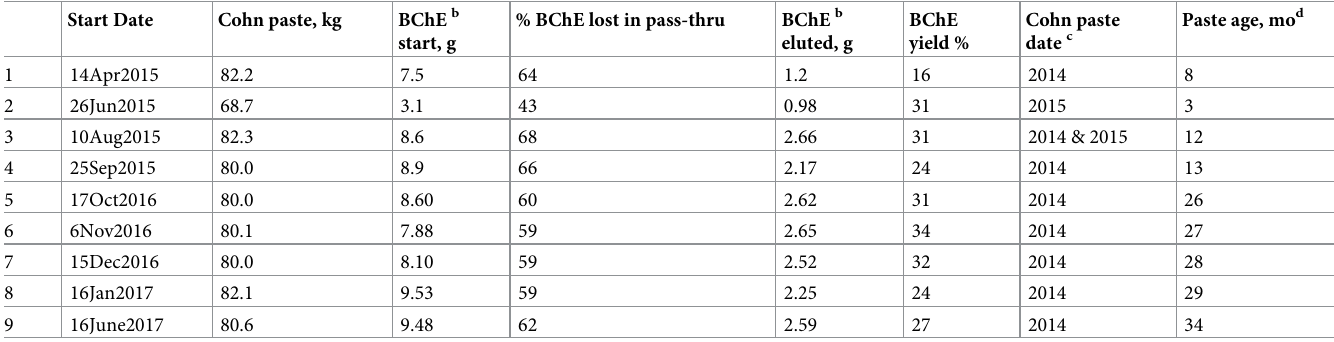
Table 1. Summary of HuBChE yield from Cohn paste extract purified on 30 L of Q-Ceramic a